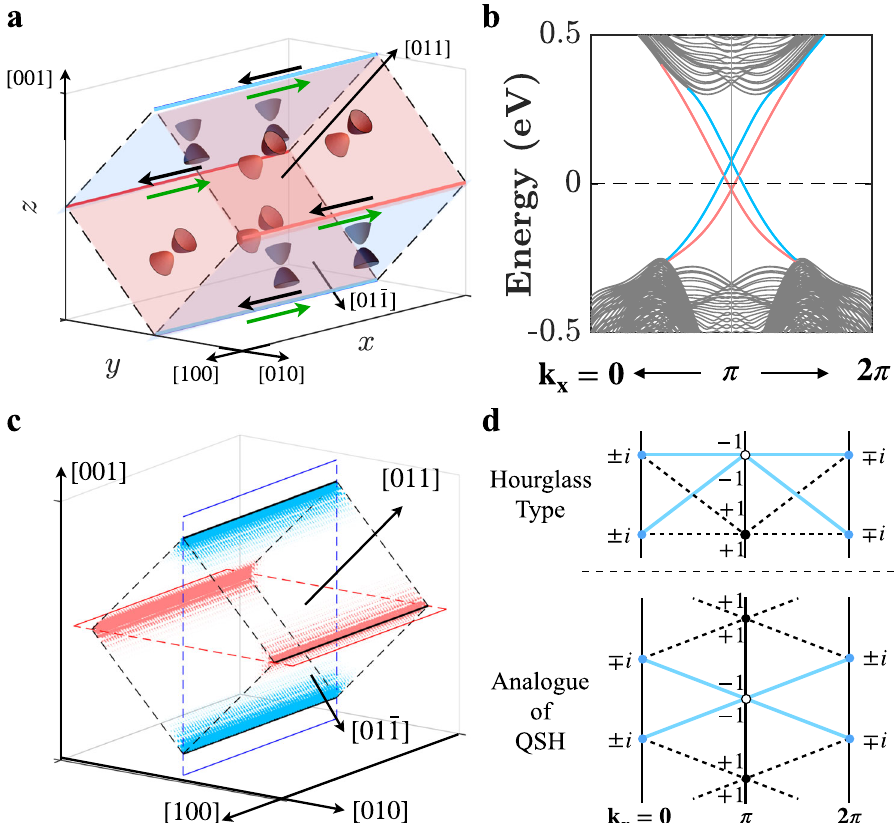
Fig. 3 Bulk-surface-hinge correspondence of the HOTI, and the band connectivity the 1D hinge states. a Geometry of the nanorod, which is periodic along the [100] direction, and fi nite-size along the [011] and ½ 011 (cid:2) directions. Two pairs of hinge modes (denoted in red and blue) emerge along the intersection lines between the (011) and ð 011 Þ facets and the (011) and ð 011 Þ facets, respectively. The fi rst (second) pair of hinge states, denoted by cyan (red), preserves the glide G y (mirror M z ) symmetry. b Energy dispersion along k x for the nanorod where the topological hinge modes are denoted with the corresponding cyan and red colors, respectively. c Distribution in real space of the hinge states of the nanorod. For purpose of clarity, on-site potentials V = 0.2 eV are added for the hinges. d Schematic of two symmetry-allowed band connectivities of the hinge states (cyan) protected by glide symmetry G y